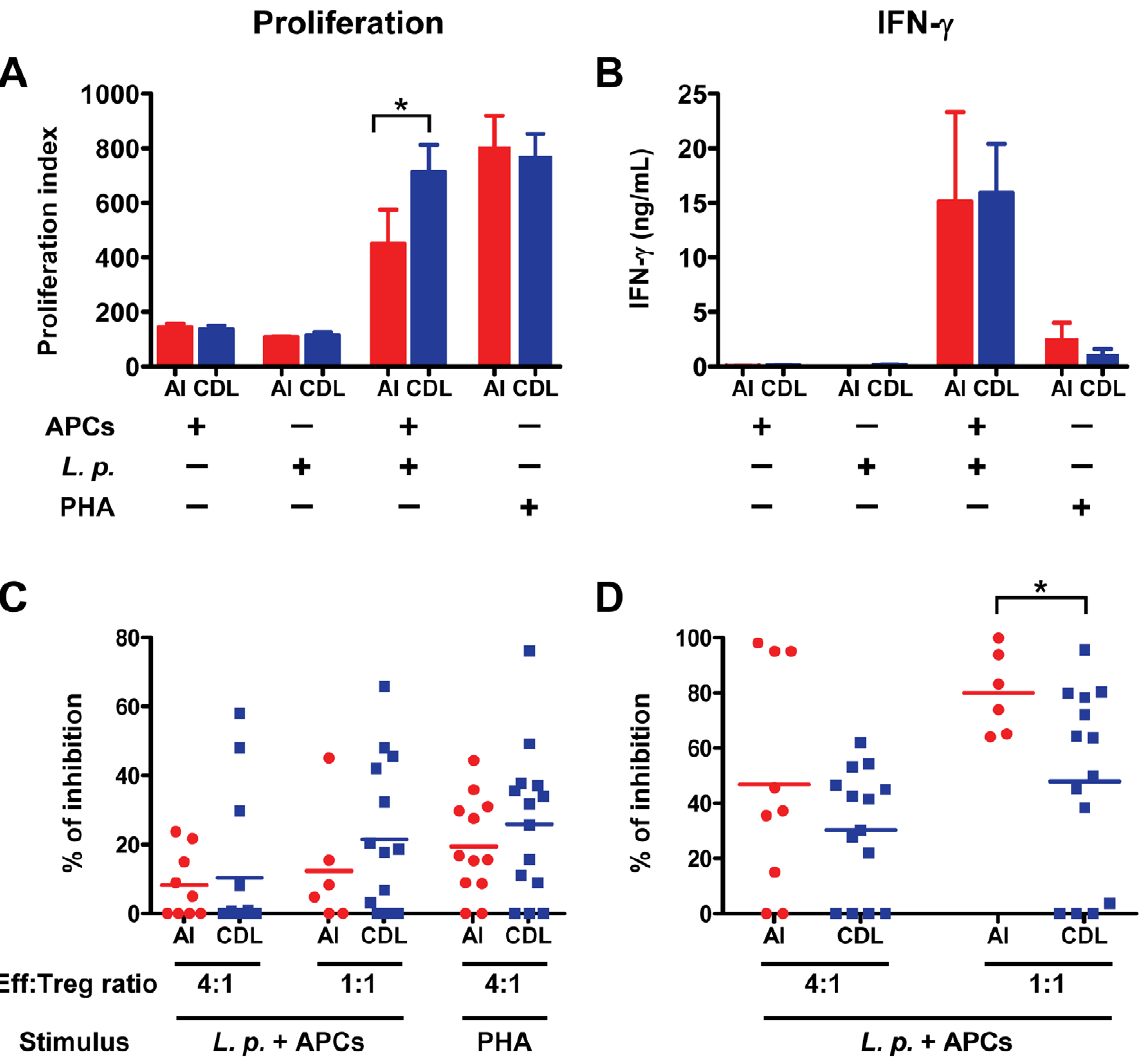
Figure 2. CD4 + CD25 + cells from AI have a higher capacity to suppress IFN- c secretion by effector cells. CD4 + CD25 2 (effector) cells from AI (n=12) and CDL patients (n=14) were cultured for 5 days with antigen presenting cells (APCs), L. panamensis ( L.p. ), or both, or with PHA, as indicated. A . Proliferation of CD4 + CD25 2 cells. B . IFN- c levels secreted by CD4 + CD25 2 cells. Positive proliferation and IFN- c secretion were defined as levels above the mean + 2SD of control wells from the same donor. For subjects whose effector cells showed positive proliferation and IFN- c secretion (n=9 for AI and n=14 for CDL patients, L.p. + APCs stimulation; n=12 for AI and n=14 for CDL patients, PHA stimulation), cultures were conducted in the presence or absence of CD4 + CD25 + (regulatory) cells. C . Inhibition of CD4 + CD25 2 cell proliferation induced by L.p. + APCs or PHA by CD4 + CD25 + cells. D . Inhibition of CD4 + CD25 2 cell IFN- c secretion induced by L.p. + APCs by CD4 + CD25 + cells. 1:1 effector:Treg ratio could not be tested in 3 AI because insufficient numbers of CD4 + CD25 + cells were obtained (n=6 for AI and n=14 for CDL patients); *p , 0.05, Mann-Whitney test. A and B show means with SEM. C and D show the mean as a horizontal line.